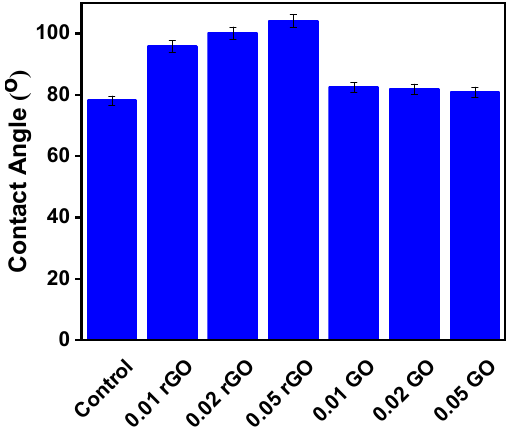
Figure 12. The water contact angle of various films.